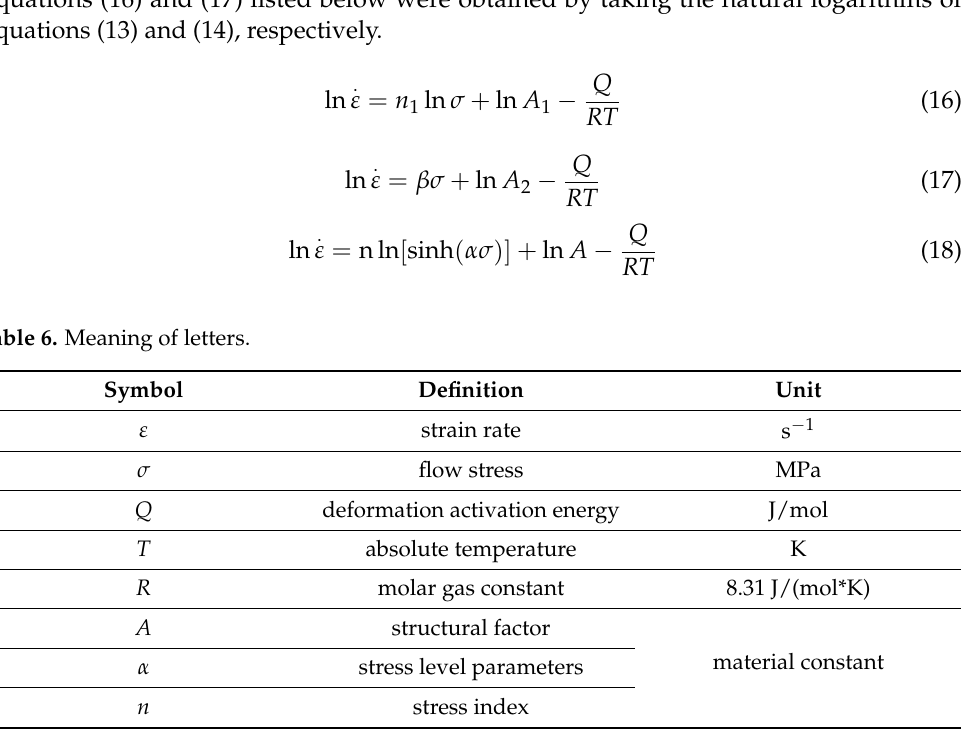
Figure 8. The relationship between ln